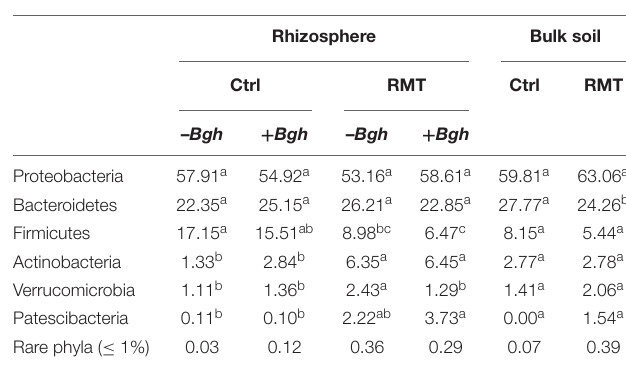
TABLE 2 | Relative abundances of microbial phyla present in barley rhizosphere and bulk soil samples, either treated with rhizosphere microbiome transplant (RMT) or as control